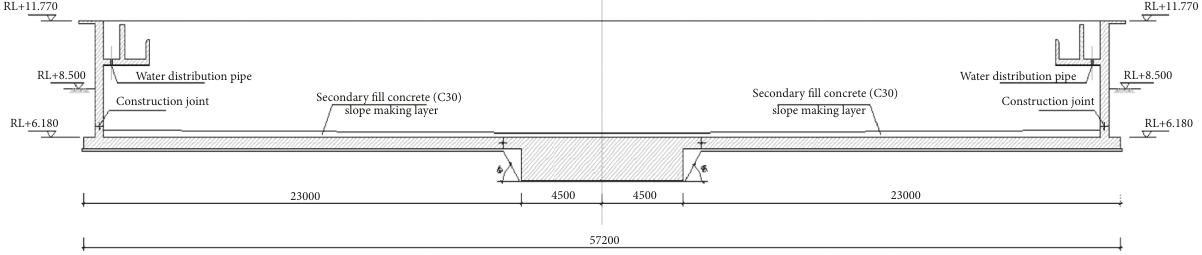
Figure 4: Typical section for SST (unit: